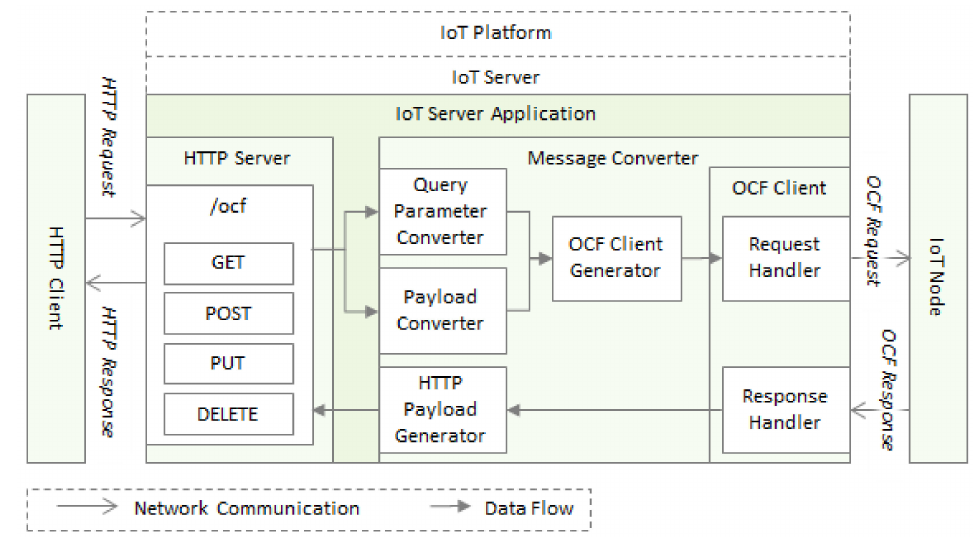
Figure 7. IoT access model based on interworking proxy.